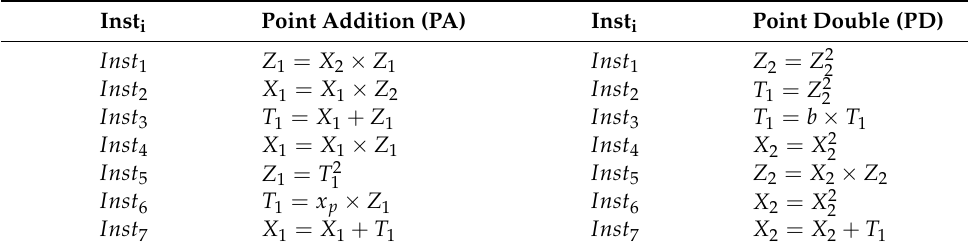
Table 1. Point addition and double